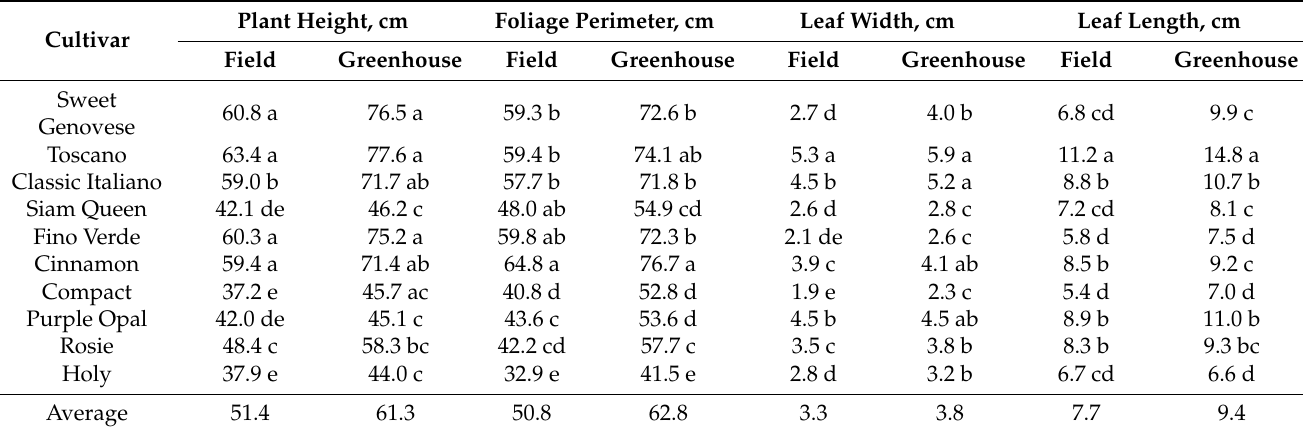
Table 1. Morphological parameters of basils grown in field and greenhouse.